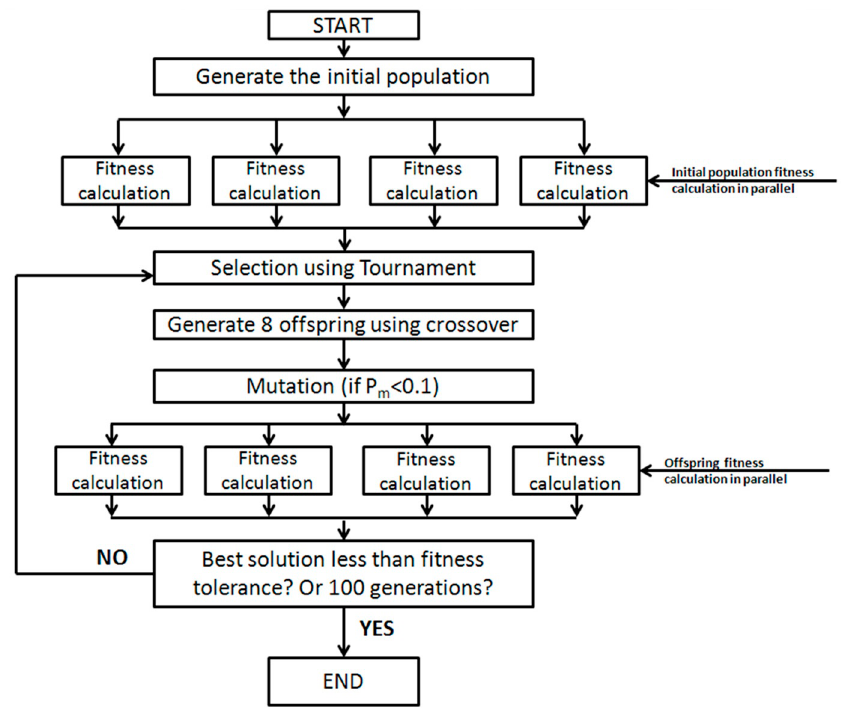
Figure 1. Illustration showing the flow of a parallel genetic algorithm (PGA).